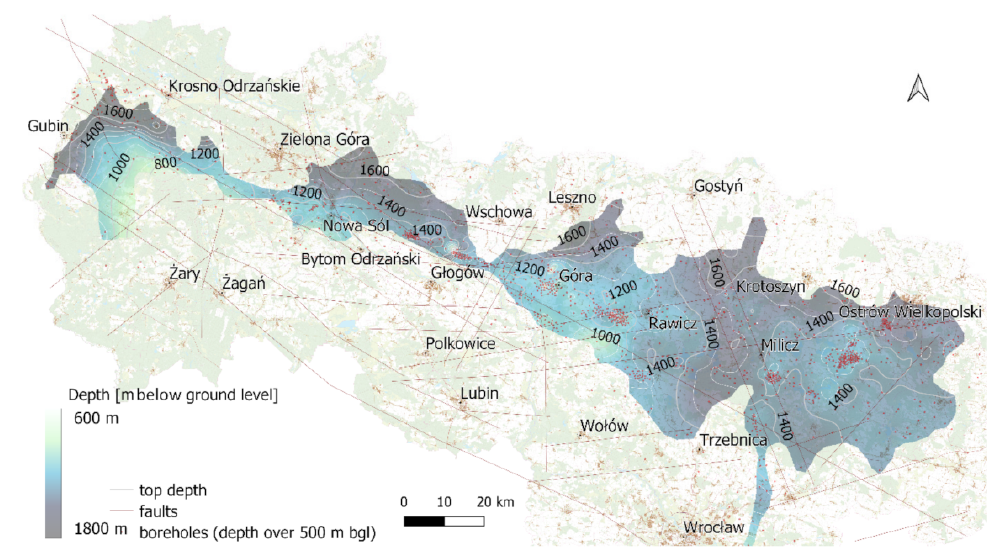
Figure A4. The top depth map of the oldest rock salt (Na1) layer to a depth of 1800 m